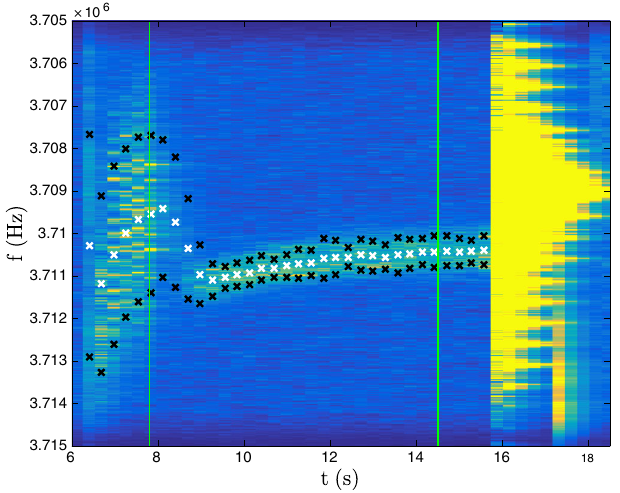
FIG. 3. Time evolution of the rms longitudinal momentum spread, σ δ , during the 650 keV energy plateau in the presence of electron cooling. Green and red vertical lines highlight the activation time of the scraper and the time window corresponding to the signal seen on scintillators,